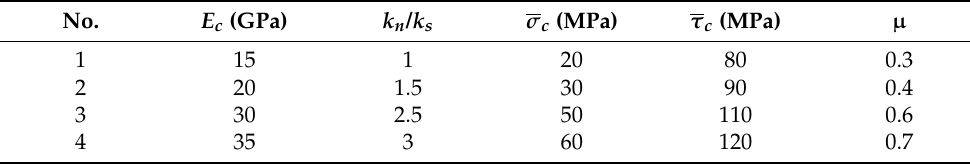
Table 2. Four values of each parameter for sensitivity analysis.